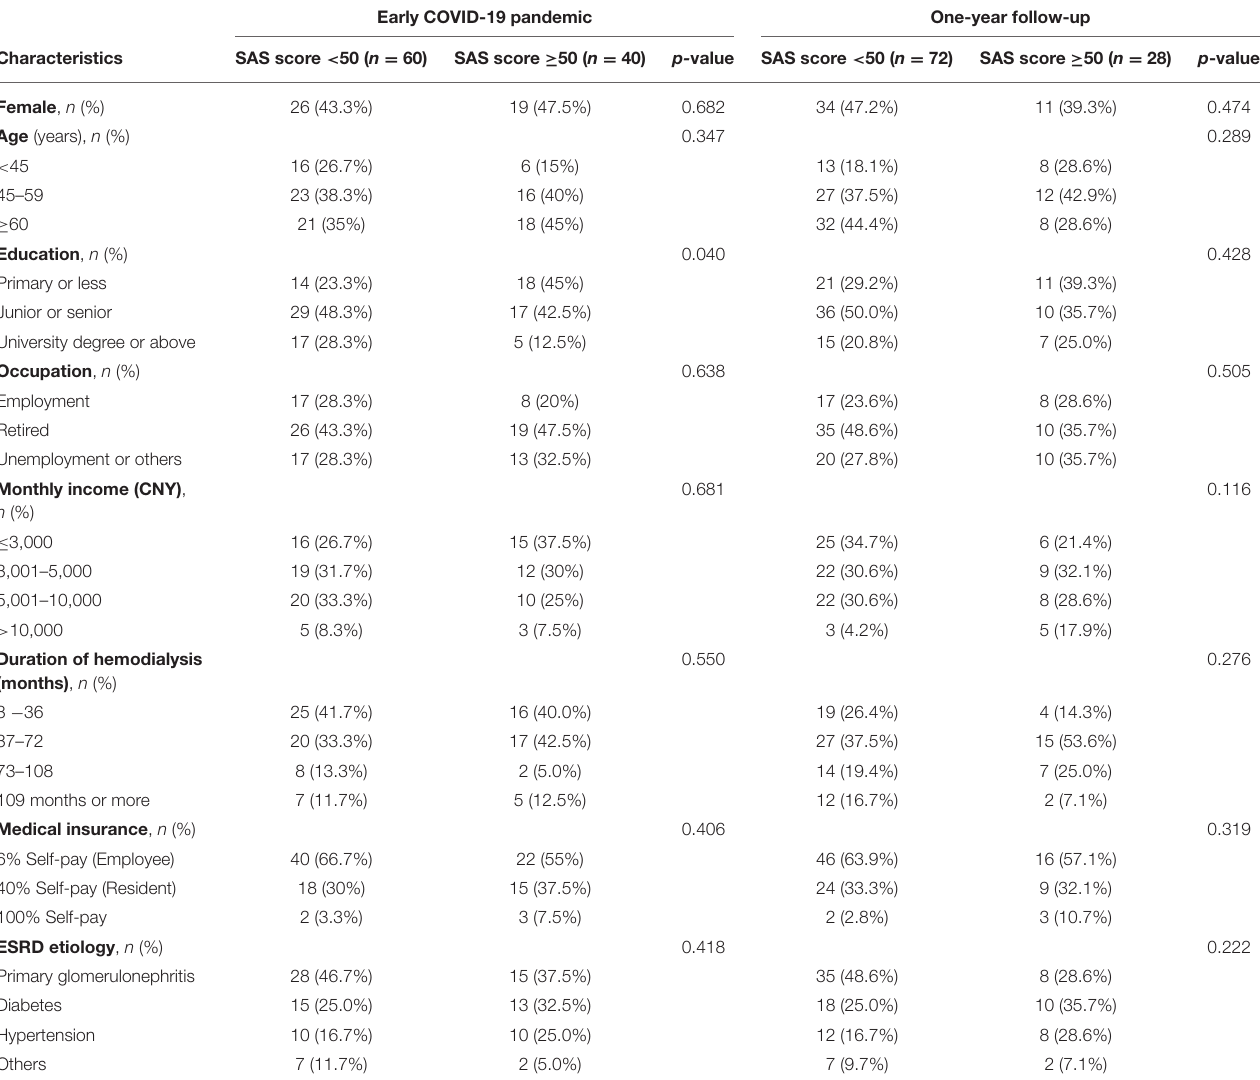
TABLE 2 | Demographic characteristics of hemodialysis patients with and without elevated anxiety symptoms during the early COVID-19 pandemic and at 1-year follow-up ( n = 100). Early COVID-19 pandemic One-year